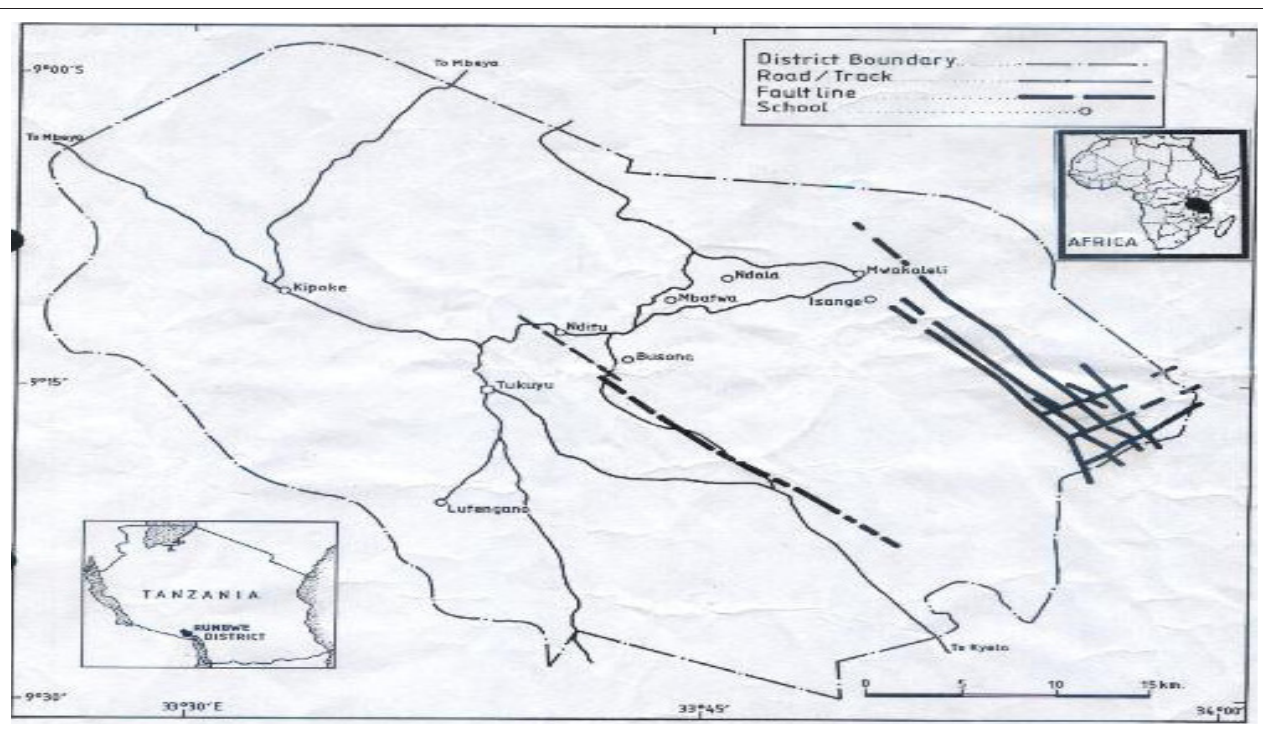
FIGURE 3: Map of Rungwe District showing major fault lines and areas included in the